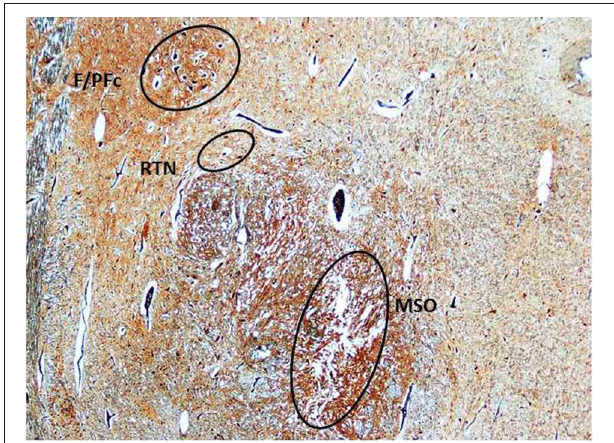
FIGURE 7 | Triple hypoplasia of MSO, retrotrapezoid nucleus, and facial/parafacialcomplex in a SIDS victim 2 month-old. Klüver–Barrera stain. Magnification: 4 × F/PFc, facial/parafacial complex; MSO, medial superior olivary nucleus; RTN, retrotrapezoid